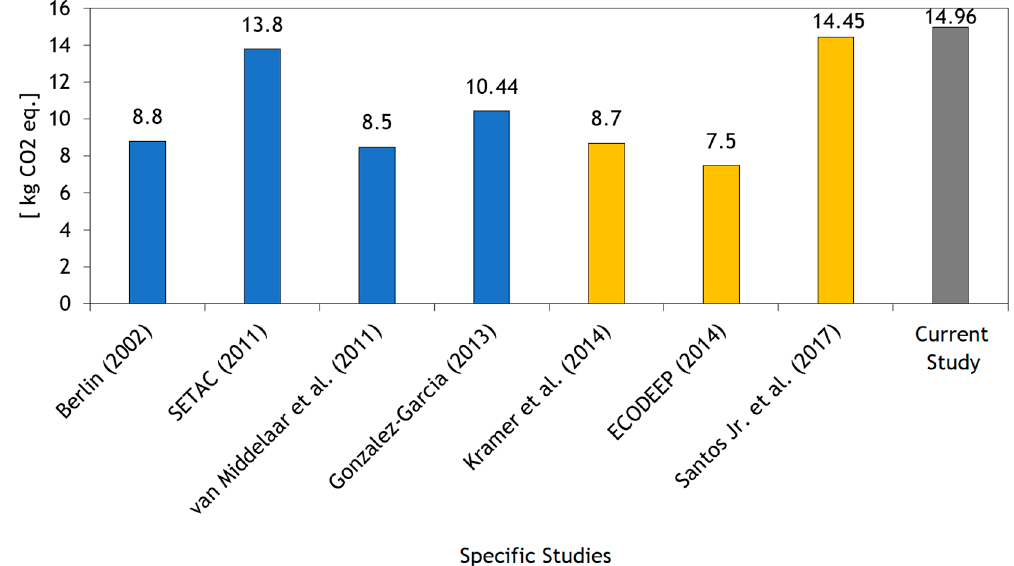
Figure 9. Climate change results comparison with similar studies.